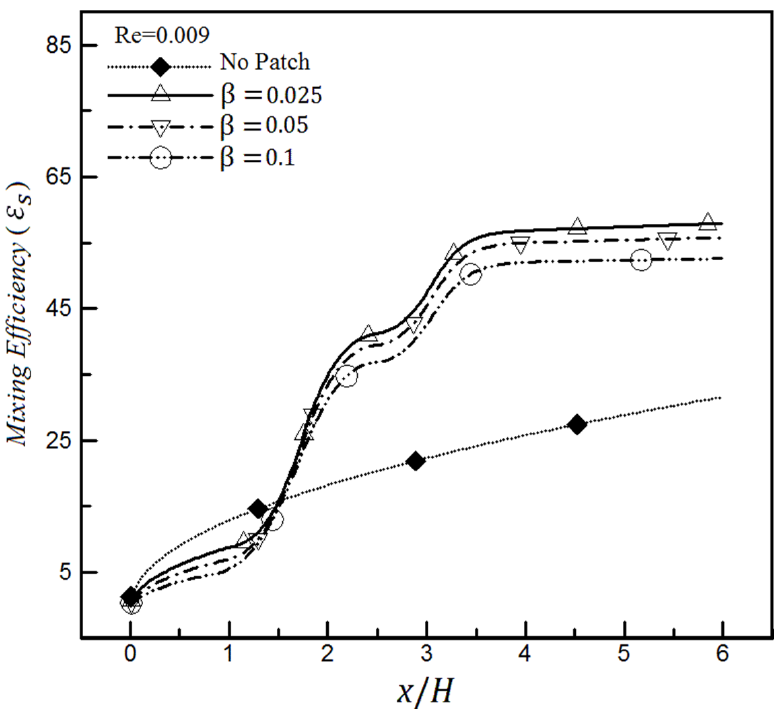
Figure 16. Mixing efficiency changes based on mixing entropy index inside the heterogeneous microchannel for different slip coefficients, Re = 0.009, and a comparison with the homogeneous channel.